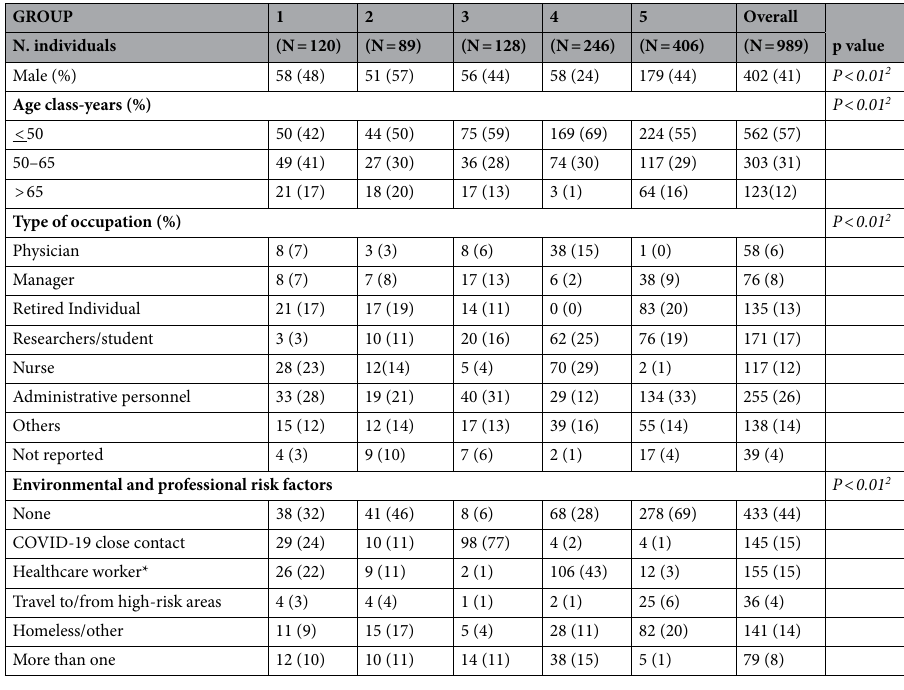
Table 1. Main characteristics of the individuals enrolled in the 5 study groups. *Healthcare workers with multiple risk factors are included in the category ‘More than